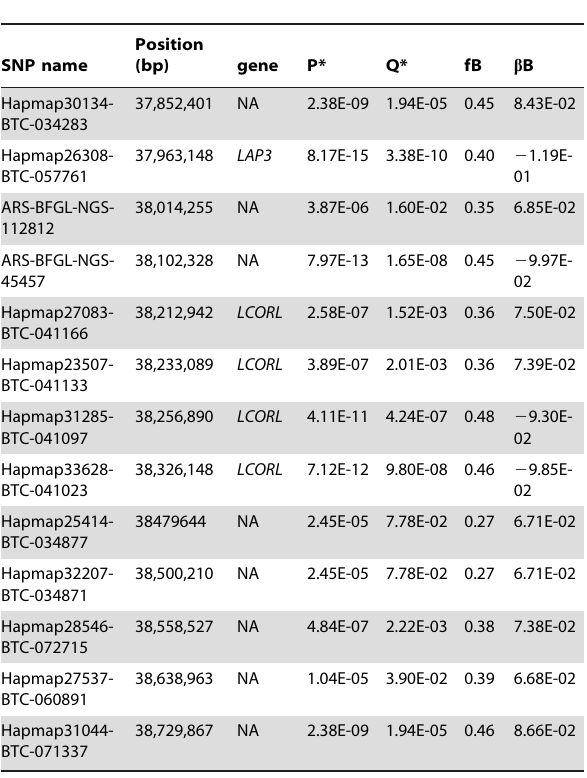
Table 1. Single nucleotide polymorphisms associated to direct calving ease and located on BTA6 in the region comprised between 37 and 39 millions of base pairs sorted according to their position on the Illumina BovineSNP50